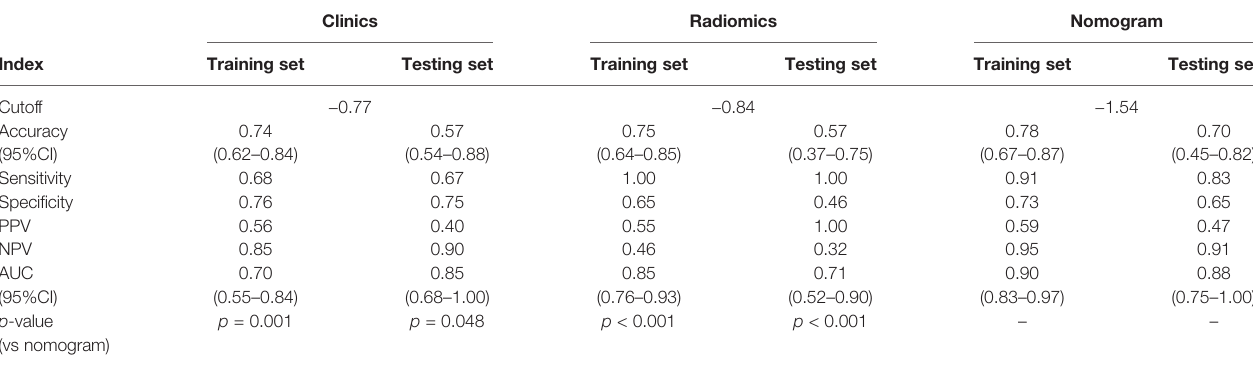
TABLE 4 | The AUC outcomes of clinical, radiomic, and combined model in prediction of csPCa in category 3 lesions.